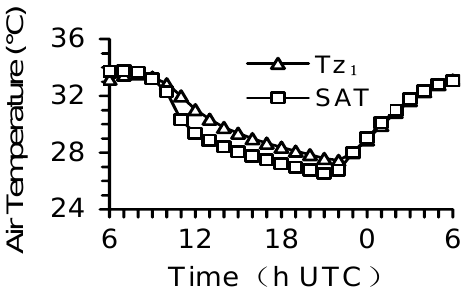
Figure 14. The mean hourly variations of 2m air temperature (SAT) and the air temperature at the lowest model level ( T z 1 ) in the CTL run for 20–29 July